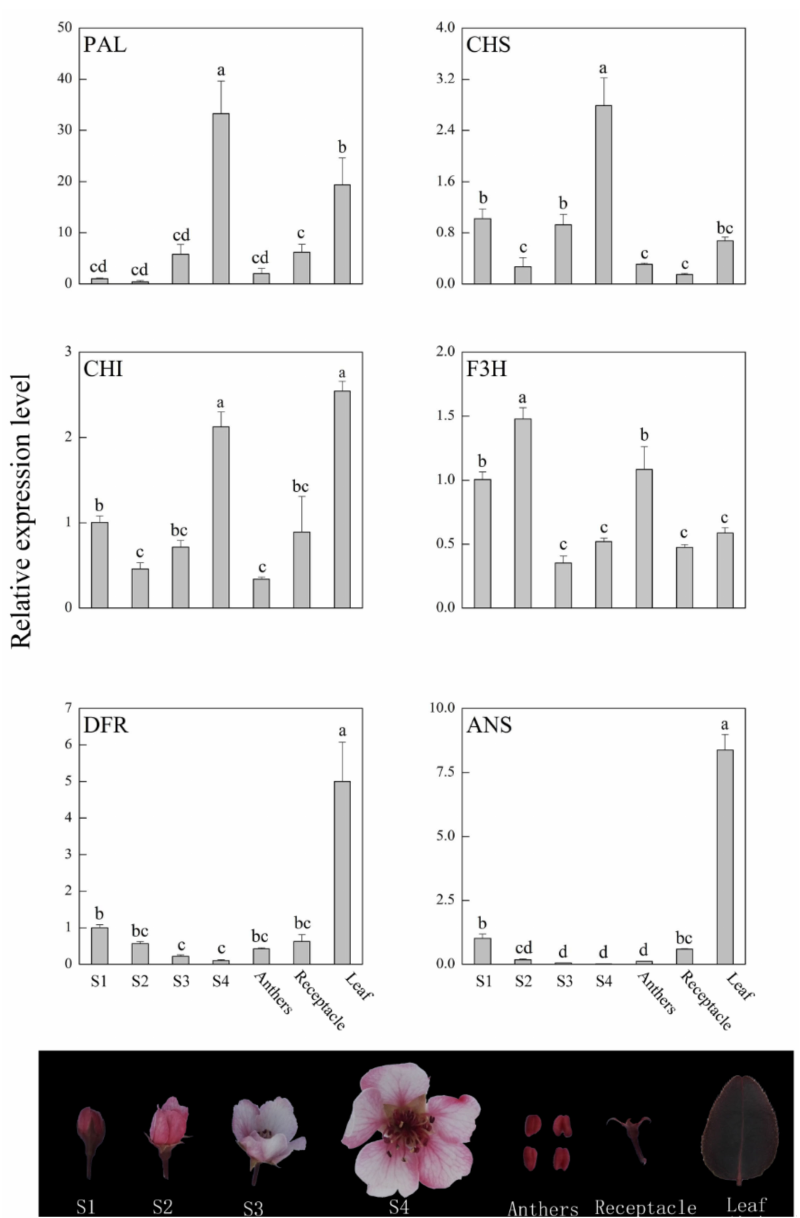
Figure 5. Expression patterns of the anthocyanin biosynthetic genes in different tissues. S1, bud stage; S2, initial flowering stage; S3, semi-open flowering stage; S4, full-bloom stage. Different lowercase letters indicate significant differences by ANOVA and Duncan’s test at p <